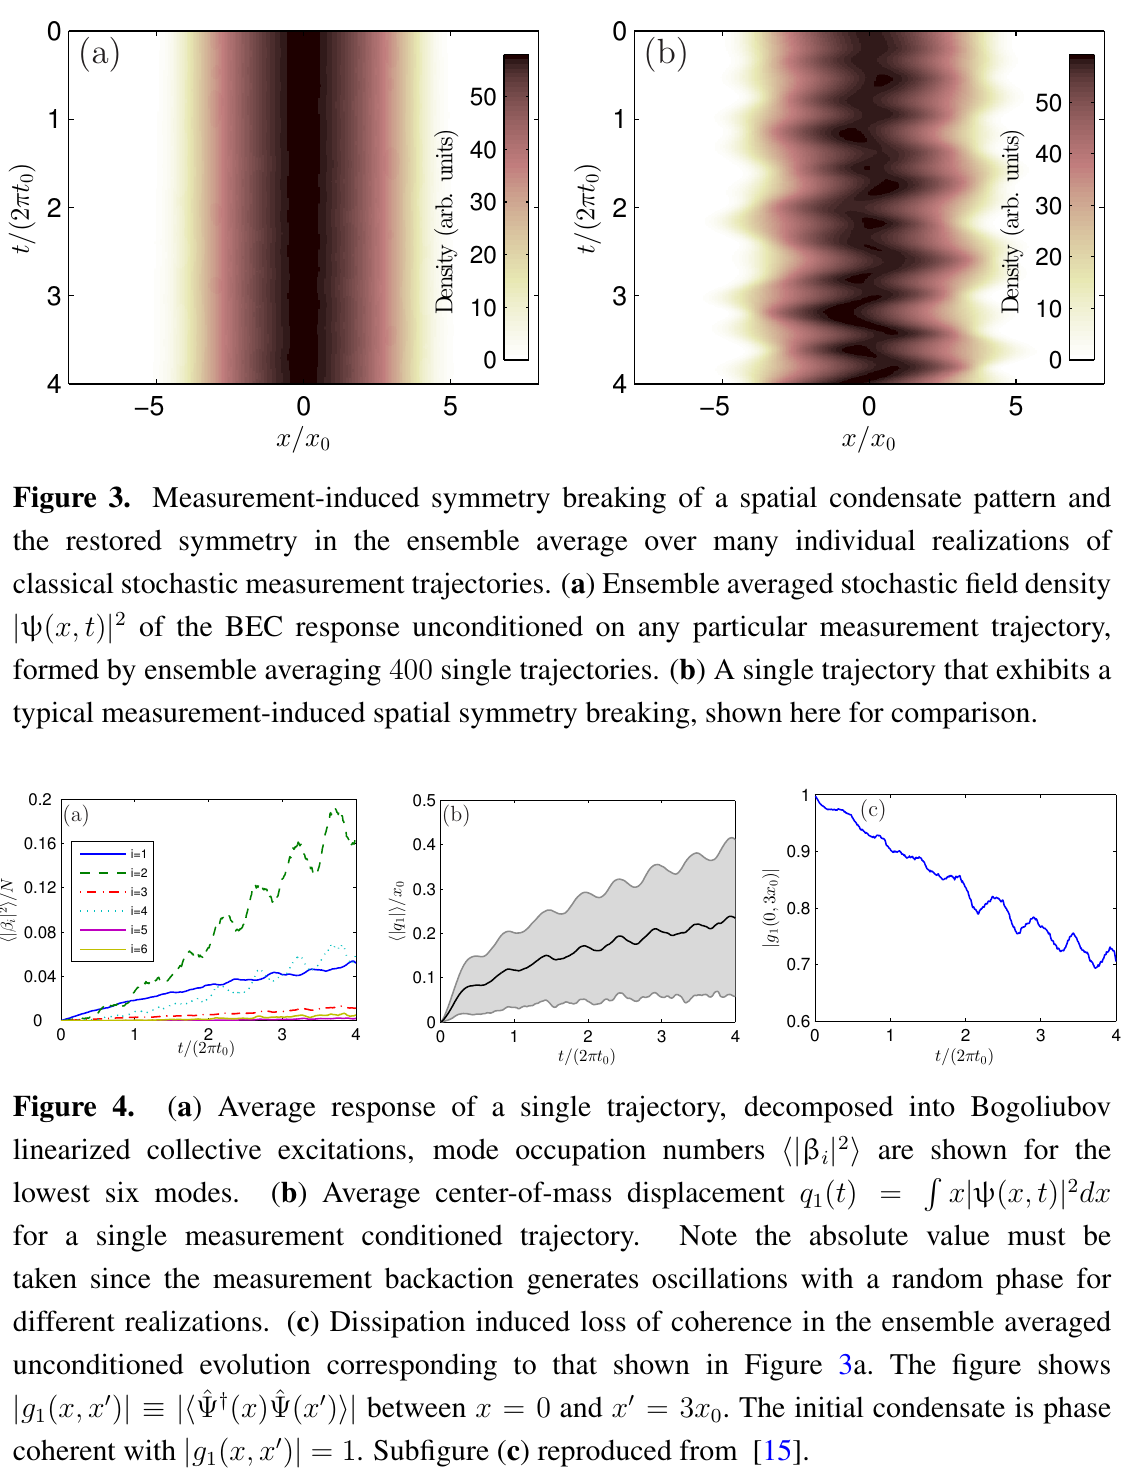
| 2 (cid:105) are shown for the i (cid:82) x | ψ ( x, t ) | 2 dx ( t ) = 1